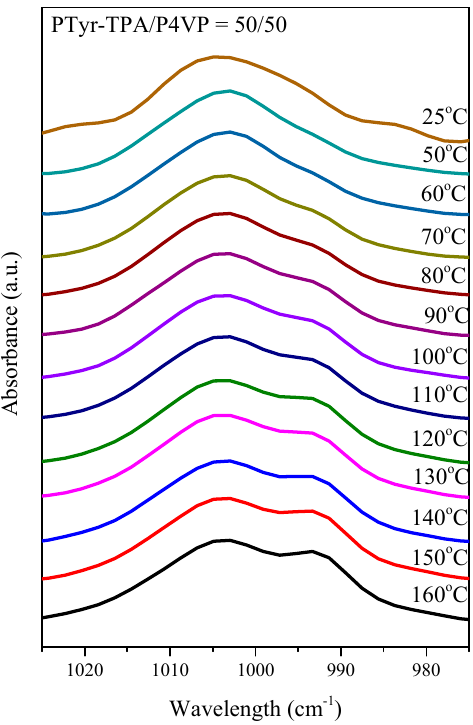
Figure 15. FTIR spectra of the PTyr-TPA/P4VP = 20/80 blend in the solid state, recorded at various temperatures.